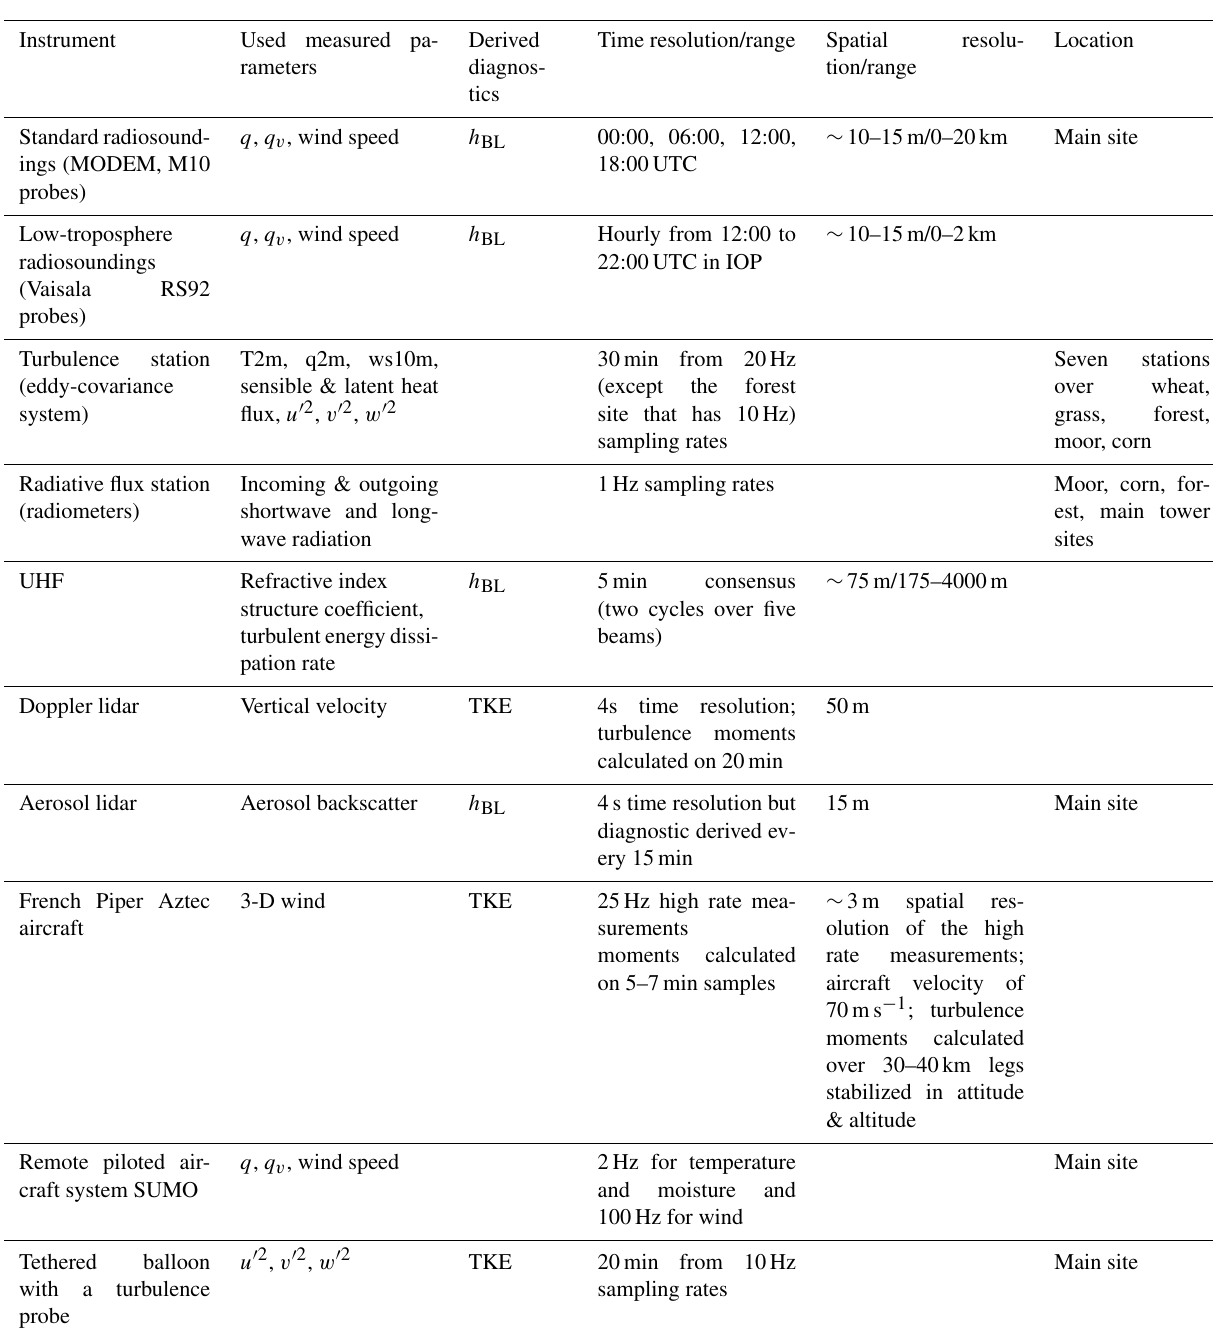
Table 1. List of the instruments and their spatial and temporal resolutions. Time resolution/range Spatial resolu- Instrument Used measured pa- Derived tion/range rameters diagnos- tics